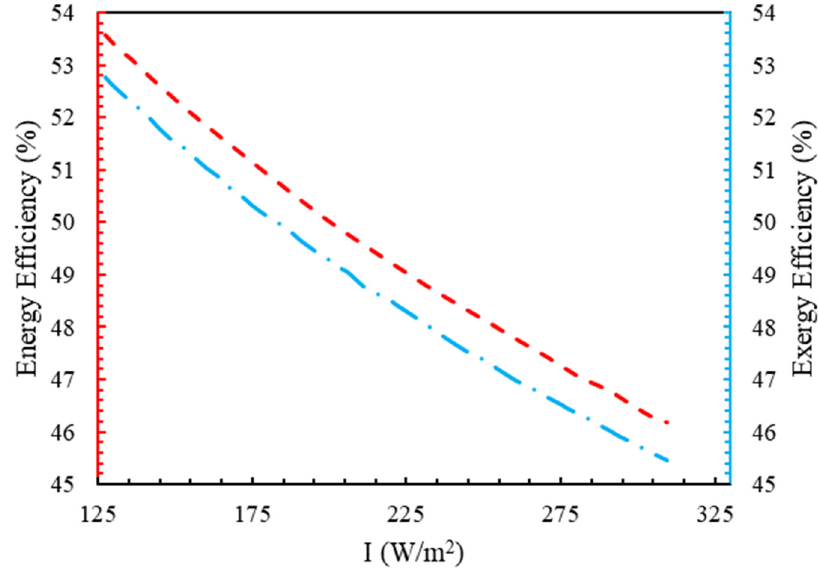
Figure 10. The trend of energy and exergy in terms of radiation intensity.